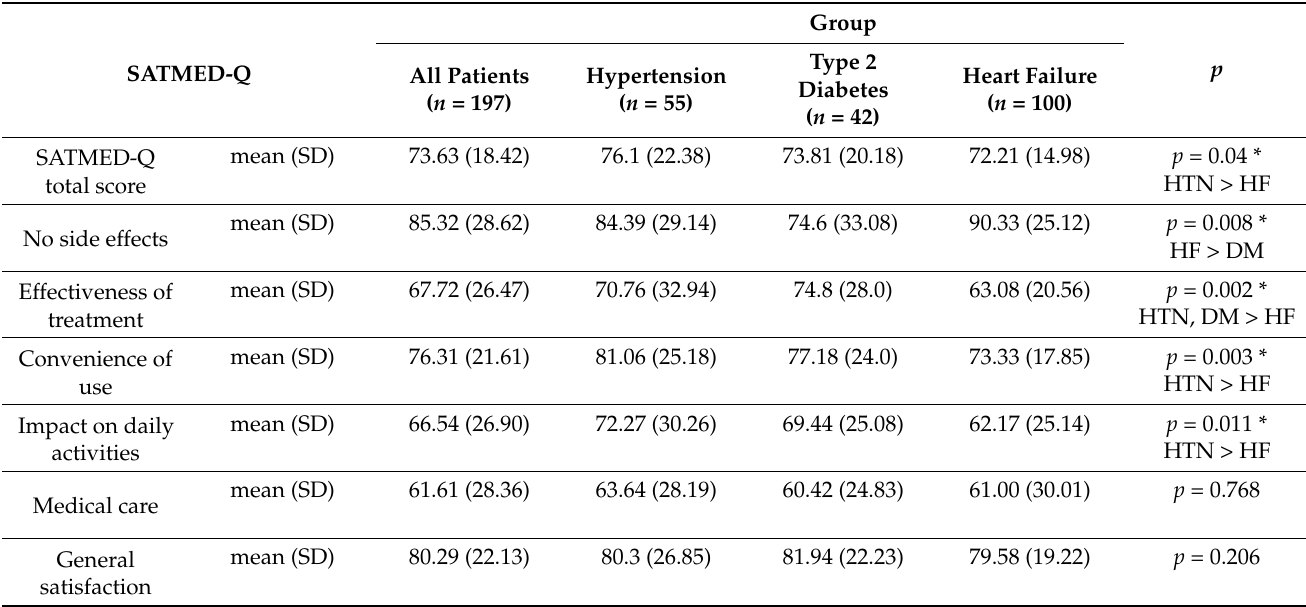
Table 2. SATMED-Q